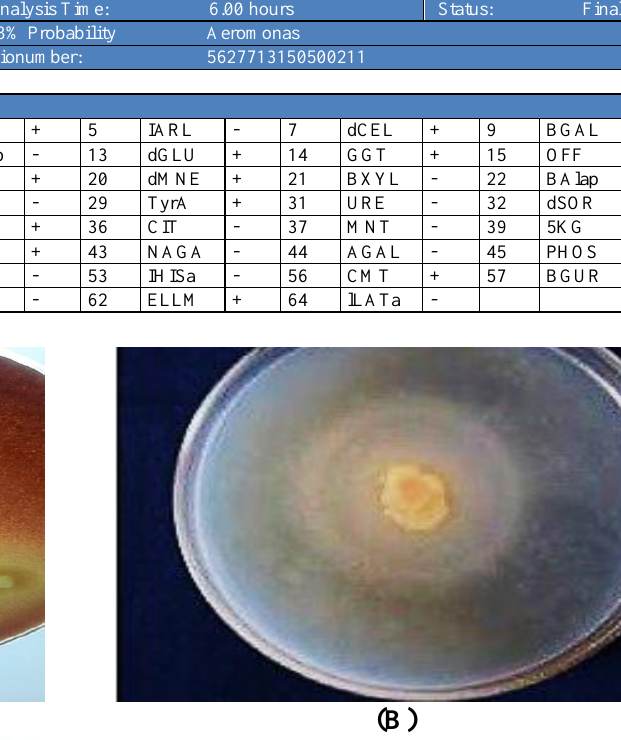
Figure, 2: (A) Protease production by Aeromonas spp. (B) Lipase production by Aeromonas Spp.